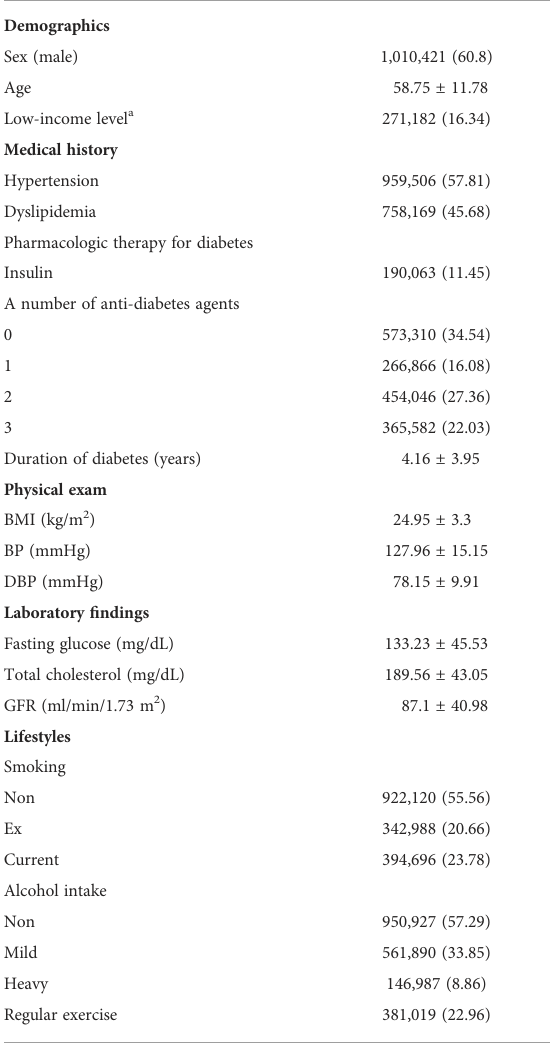
TABLE 1 Baseline characteristics of overall study